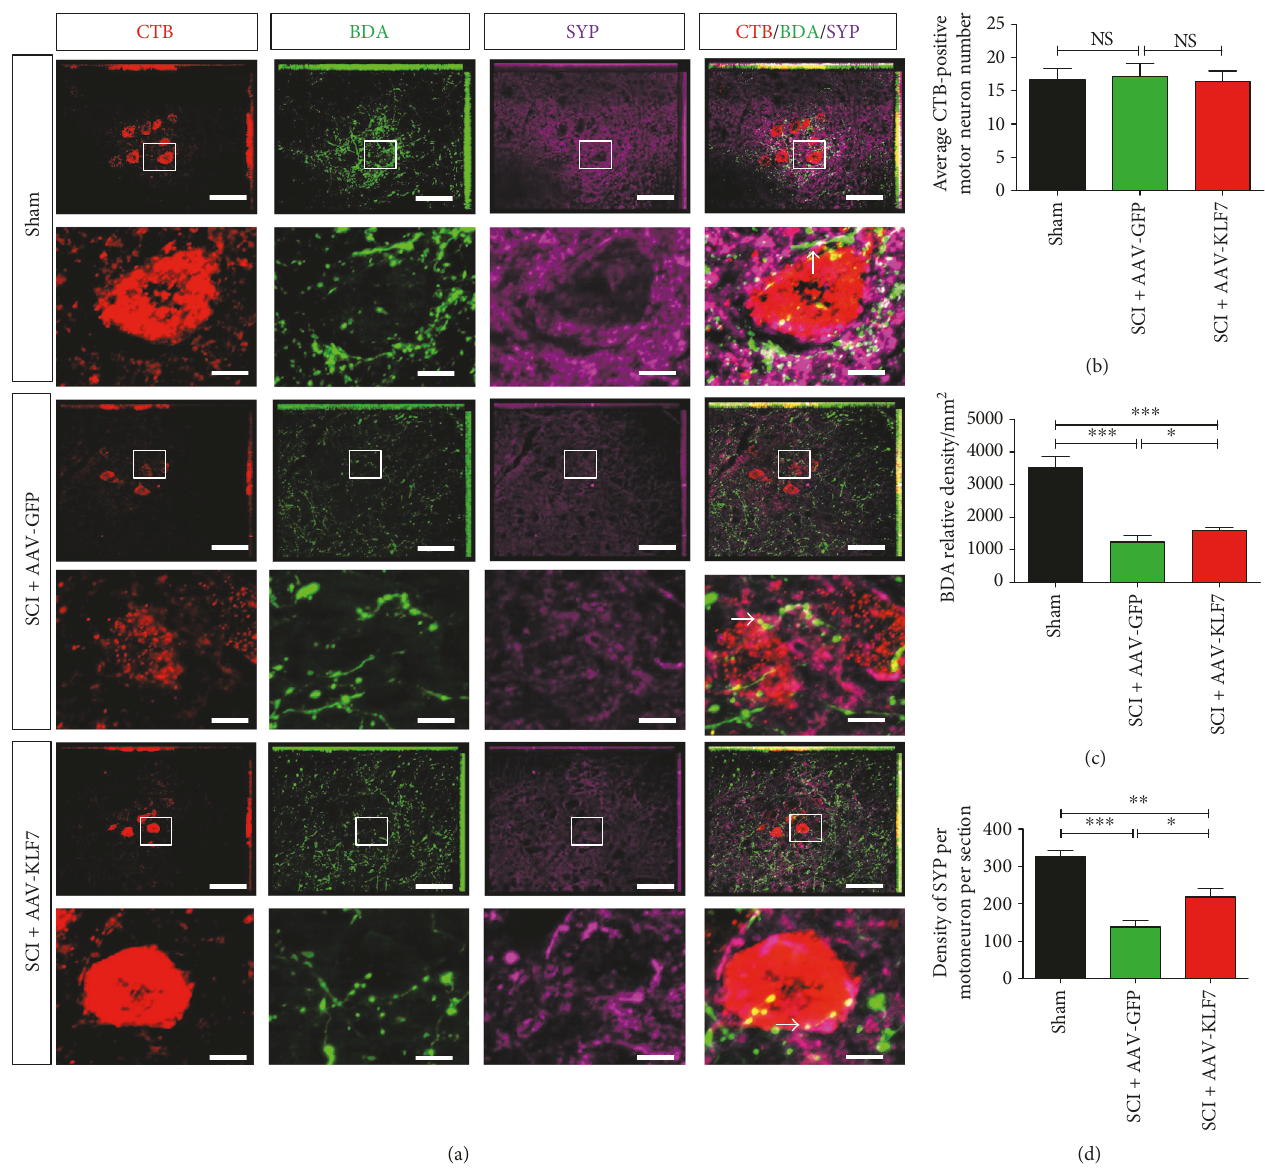
Figure 10: AAV-KLF7 promotes DPSN axonal plasticity and induced synapse formation with motor neurons at the caudal spinal cord. (a) Contact between motoneurons (CTB retrogradely labeled, red) and DPSN axons (BDA-labeled, green) and synapse formation (synaptophysin-labeled, purple) are shown. Block indicates the new synapses formation (white) between DPSN axons and motoneurons. Quantitative analyses of the motor neuron targeted CTB-labeled axons (b), BDA relative density (c), and SYP density per motoneuron per section (d) at the caudal spinal cord. n = 6 mice/group. ∗ P < 0 05 , ∗∗ P < 0 01 , and ∗∗∗ P < 0 001 . NS: not signi fi cant. One-way ANOVA, Tukey ’ s post hoc test. Scale bars: 100 μ